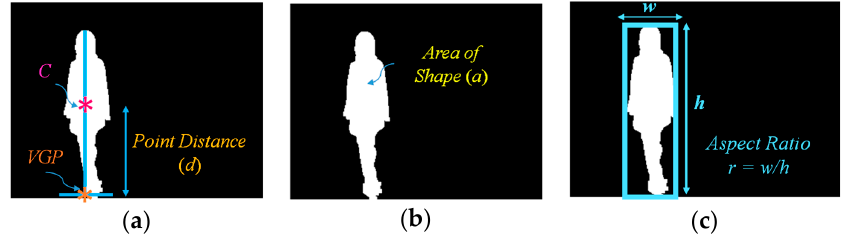
Figure 2. Feature extraction: ( a ) Point distance ( d ); ( b ) area of the object ( a ); ( c ) aspect ratio of the object ( r ).